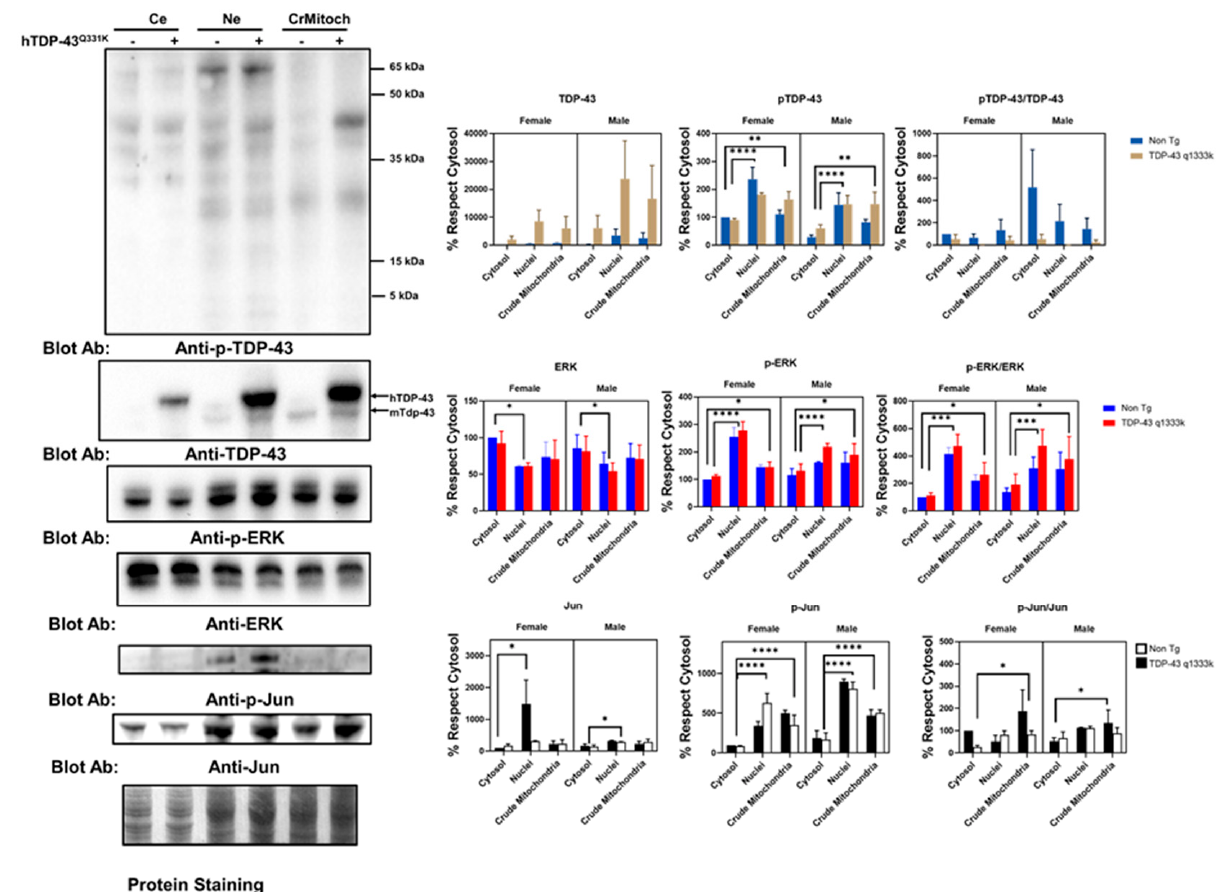
Figure 2. Cellular subfractionation evidence for the in vivo colocalization of the proteins implicated in neurodegeneration with the mitochondrial components. As shown by the Western blot analyses of brain lysates after subcellular fractionation, in addition to the nuclear-enriched (Ne) and cytosolic-enriched (Ce) compartments’ crude mitochondrial fractions (CrMitoch), both non-transgenic and transgenic hTDP-43 mice show the presence of p-TDP-43, p-ERK, and Jun. The levels were quantified by densitometry in the brains from 90-day-old mice. The Western blots shown are for female specimens. Right panels indicate the quantitative analyses. Bars indicate the mean values with lines showing the standard deviation. * Indicates p < 0.05, ** p < 0.01, *** p < 0.001, and **** p < 0.0001 by Dunnett’s post-hoc multiple comparison test after a three-way ANOVA ( n = 4 different mice from each genotype and sex). The ANOVA values are shown in the